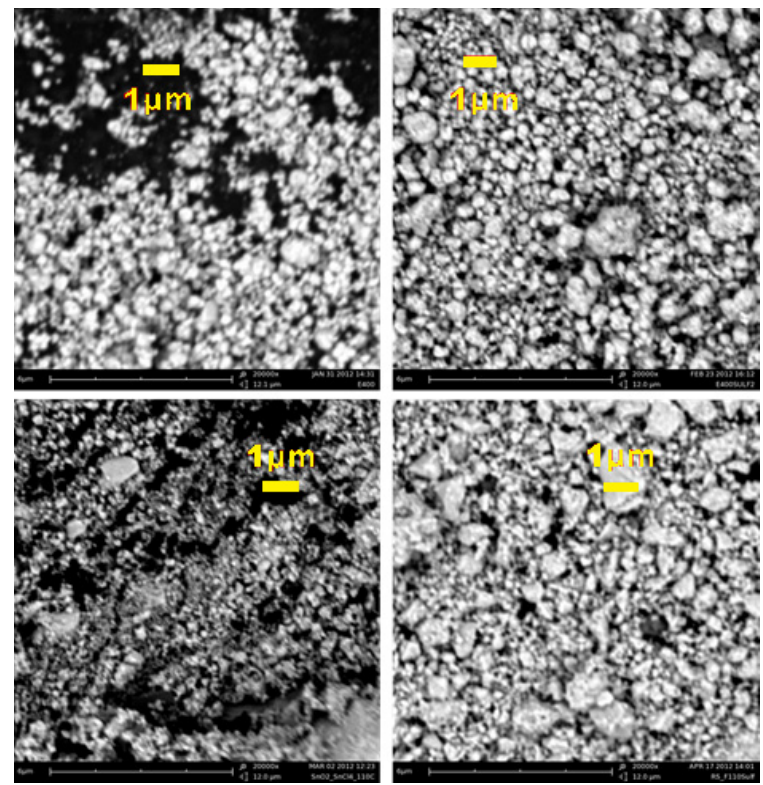
Figure 3. Scanning electron microscopy (SEM) micrographs of the four synthesized oxides. From left to right and from top to bottom: E400, E400S, F110, and F110S,